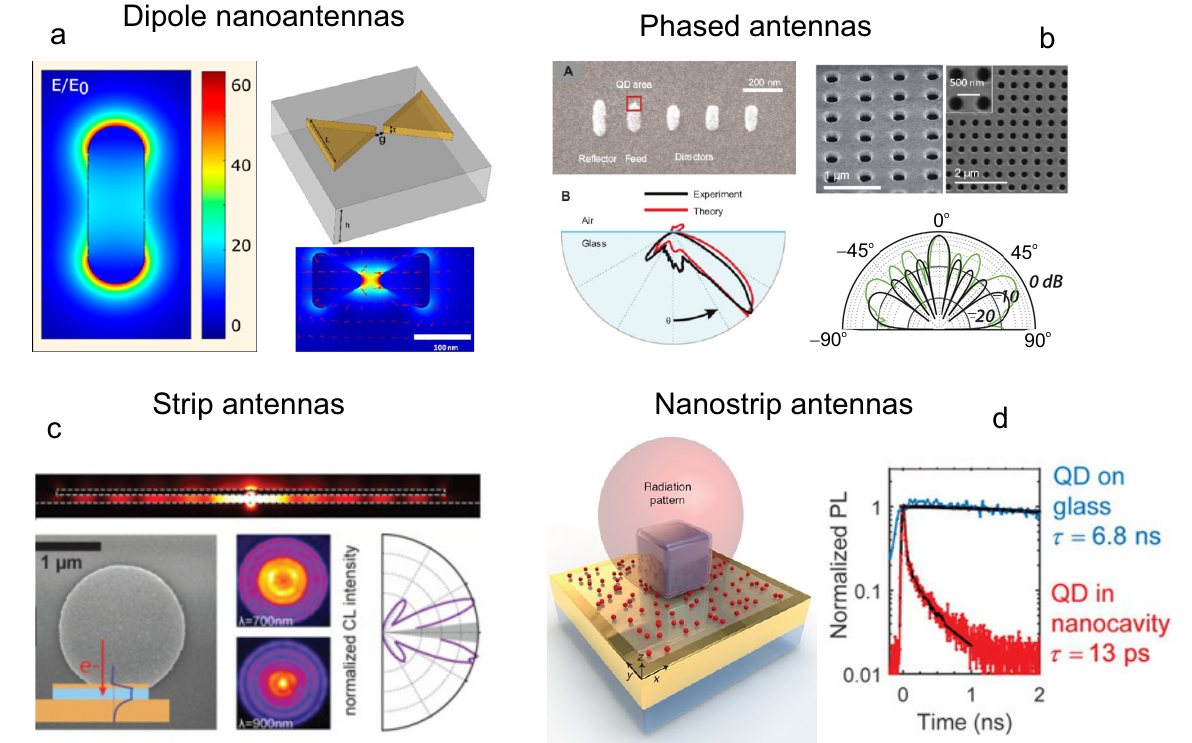
Figure 5. Single-photon nanoantennas: ( a ) Dipole antennas in the shape of nanorods and dimer/slot antennas. They have been reported to give a 1000-fold increase in the fluorescence brightness for intrinsically poor emitters in equal parts by pumping and improving LDOS. ( b ) A phased NP or antennas with nanoholes change the radiation directivity, usually, with a poor Purcell factor control. ( c ) Strip antennas are metal–insulator–metal waveguides for obtaining high LDOS. Radiation leakage from the edges is directional and depends on the size of the area. ( d ) Strip nanoantennas on the basis of a metallic NP, a dielectric, and a metal; according to the literature, they show more than 500-fold increase by Purcell and almost 2000-fold increase in brightness for really good emitters. However, although this antenna is directional to some extent, it is difficult to be